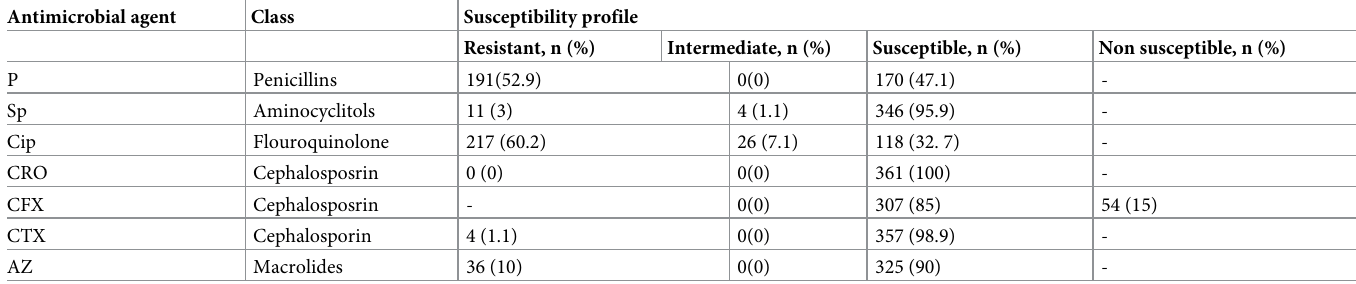
Table 4. Percent of antimicrobial susceptibility pattern of gonococcal isolates recovered from urethral discharge of patients (N = 361). Antimicrobial agent